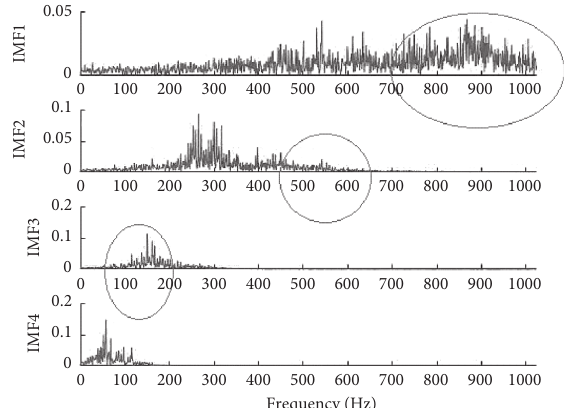
Figure 19: Amplitude-frequency of IMF1–IMF4.